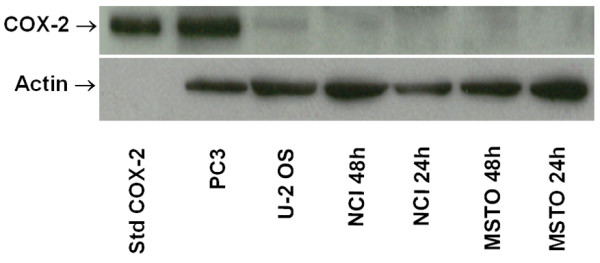
COX-2 expression level in MSTO and NCI cell lines at two different times. Ovine COX-2 standard, PC-3 (human prostate cancer cell line) lysate were used as positive controls and U-2 OS lysate as negative control. Normalization with actin level. The experiments were done in triplicate with comparable results.